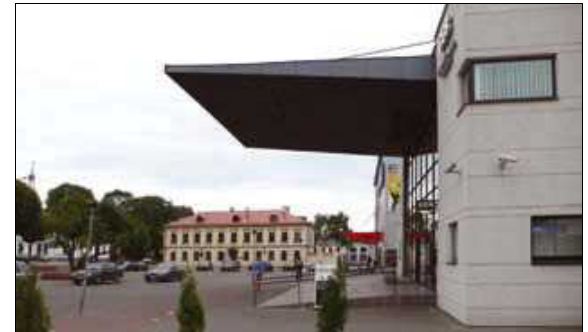
Fig. 3. “bu­itis“ shop after­ r­econstr­u­ction in kau­nas.